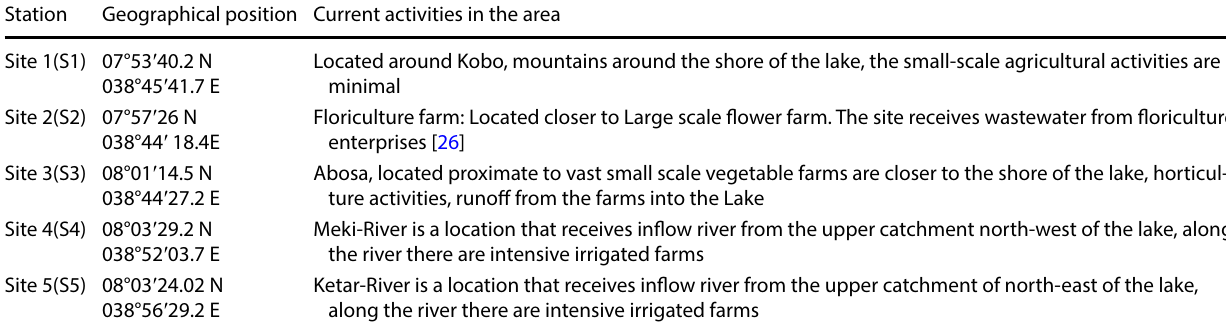
Table 1 Information related to sampling stations of the present study in Lake Ziway Station Geographical position Current activities in the